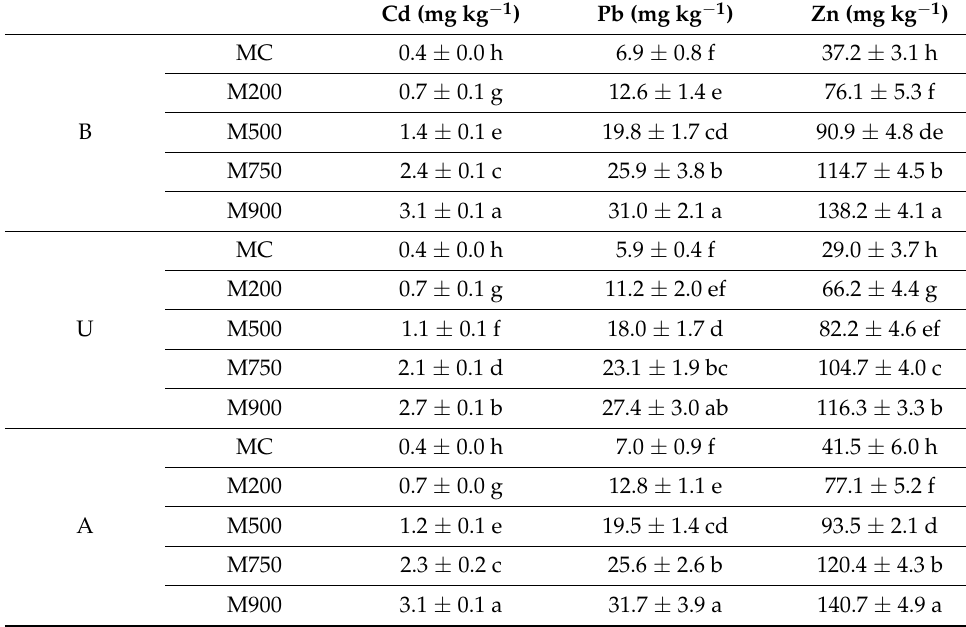
Table 2. Leaf TE concentrations of the cultivars (B, U, and A) in soils with a gradient TE concentration (MC, M200, M500, M750, and M900) at the end of the second growing period. Values are presented as means ± SD. Different letters refer to significant differences between plants (Turkey HSD test, n = 5, p ≤